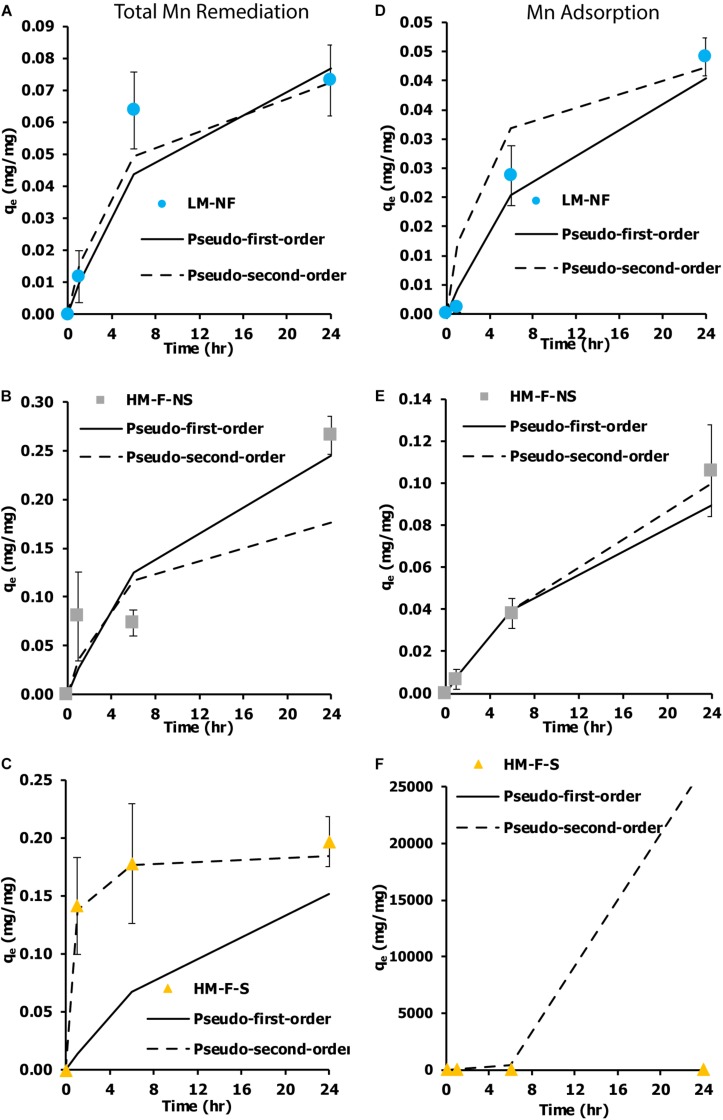
Kinetic measurement of Mn removal from the living microalgae Pediastrum duplex AARLG060 at various Mn concentrations and under various conditions. (A–C) Kinetic measurement of total Mn remediation in LM-NF, HM-F-NS, and HM-F-S. (D–F) Kinetic measurement of Mn adsorption in LM-NF, HM-F-NS, and HM-F-S. LM-NF, low Mn non-filter; HM-F-NS, high Mn filter non-sterile; and HM-F-S, high Mn filter sterile.